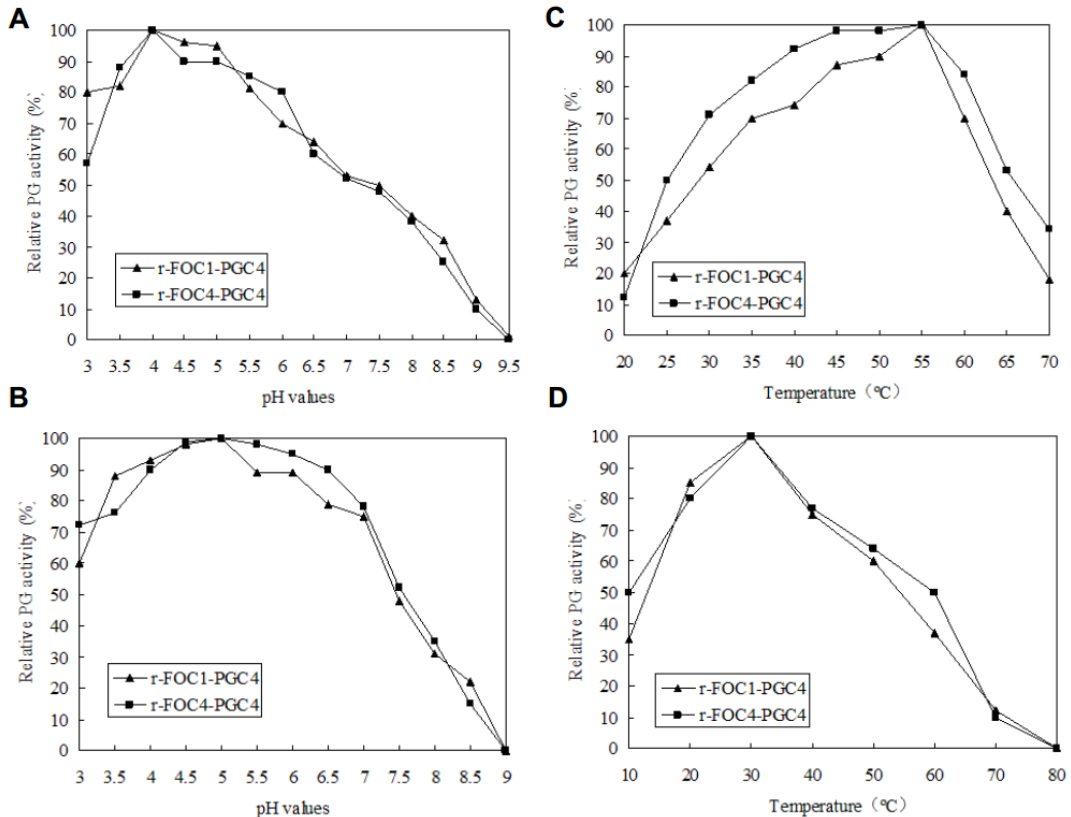
Figure 4. Enzymatic activity and stability. ( A ): Determination of the optimal pH; ( B ): enzymatic stability with respect to pH; ( C ): determination of the optimal temperature; ( D ): enzymatic stability with respect to the temperature. To determine the optimal pH, the enzyme activity was assayed using 100 mM of a potassium phosphate buffer for pH values between 3 and 10 at 50 °C, and 0.5% ( w / v ) PGA as substrates. The effect of temperature on Pgc4 activity was determined in the same buffer at pH 4.5, between 10 and 90 °C. One Unit of PG activity was defined as one μ mol/L of galacturonic acid (GA) released by enzyme·min − 1 . To estimate the pH stability, samples were incubated in 100 mM of a potassium phosphate buffer of different pH values at 4 °C for 24 h. To evaluate the thermal stability, protein samples were incubated at different temperatures in the same buffer at pH 4.5, for 2 h. The residual activity was detected according to the method as previously described.